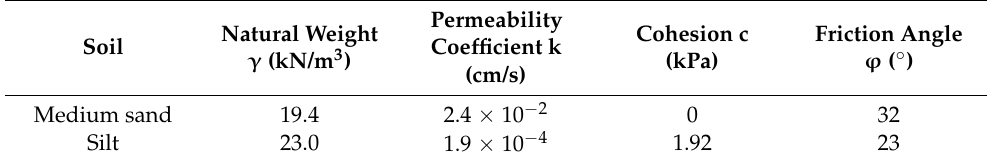
Table 1. Physical and mechanical parameters of soil material in model test.